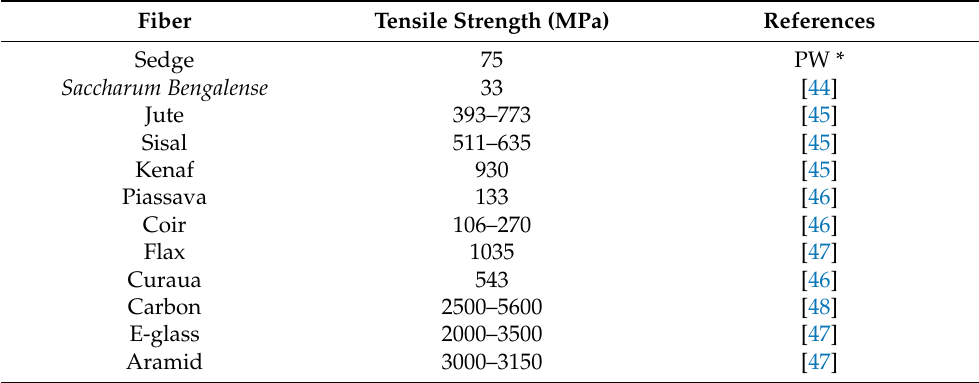
Table 2. Comparison of sedge fibers tensile strength with different NLFs and synthetic fibers.